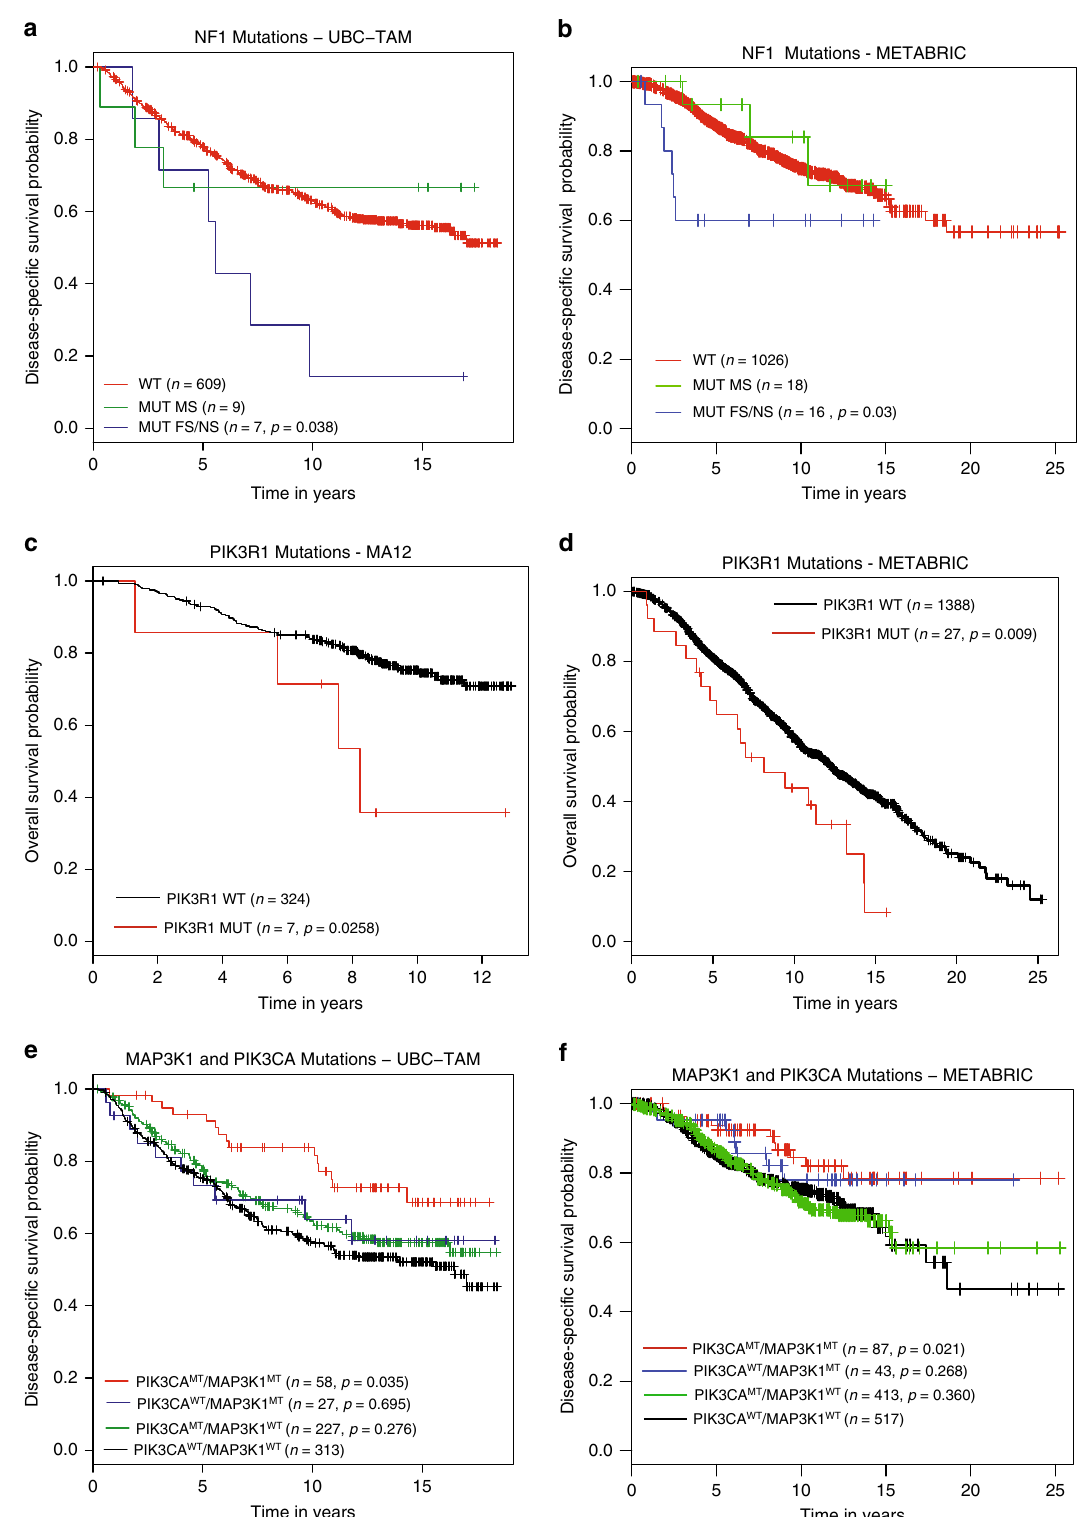
Fig. 7 Kaplan – Meier plots of candidate gene mutations in discovery and validation cohorts. a , b Kaplan – Meier graphs showing the prognostic role of NF1 mutations, separated by variant type — Missense (MUT MS, green), Frameshift/Nonsense (MUT FS/NS, blue) in ER + breast cancer patients from a UBC- TAM and b METABRIC cohort establishing the association between FS/NS mutations in NF1 with poor prognosis. c , d Kaplan – Meier graph showing the prognostic role of PIK3R1 in c MA12 and d METABRIC ER + breast cancer patients, categorized based on tumors with wild type (WT, black) or mutated PIK3R1 non-silent mutations (MUT, red). e – f Kaplan – Meier graph demonstrating co-occurrence of non-silent mutations in MAP3K1 and PIK3CA (red) in e UBC-TAM and f METABRIC associates with better survival when compared against tumors with mutations exclusively in MAP3K1 (blue) or PIK3CA (green) or wild type for both MAP3K1 and PIK3CA (black). p , log rank test p